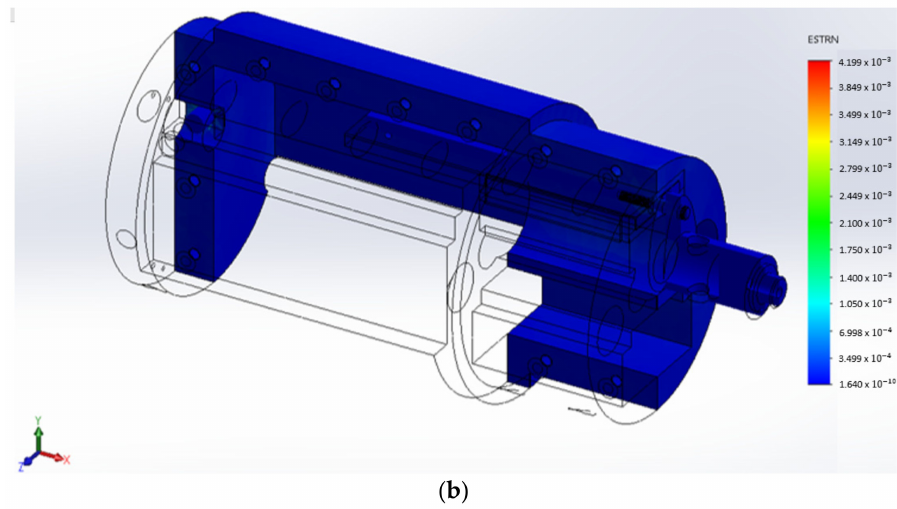
Figure 8. Strain FEM simulation when the maximum torque is exerted by the actuator rod: ( a ) extended; ( b ) retracted.